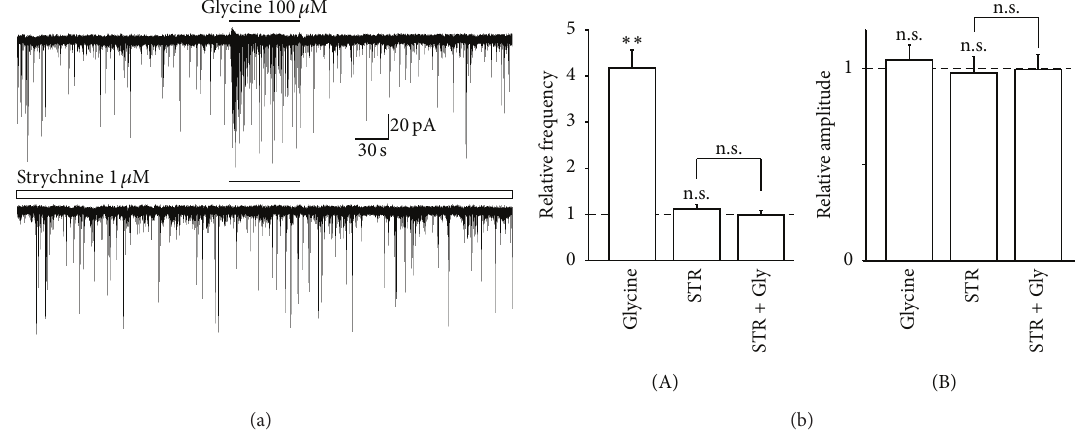
Figure 3: Effect of strychnine on glycine-induced increase in sEPSC frequency. (a) Typical traces of glutamatergic sEPSCs observed during the application of 100 𝜇 M glycine in the absence (upper) and presence (lower) of 1 𝜇 M strychnine. (b) Glycine-induced changes in frequency (A) and amplitude (B) of sEPSC in the absence and presence of strychnine. Each column was the mean and SEM from 6 neurons. ∗∗ 𝑃 < 0.01 ; n.s.: not